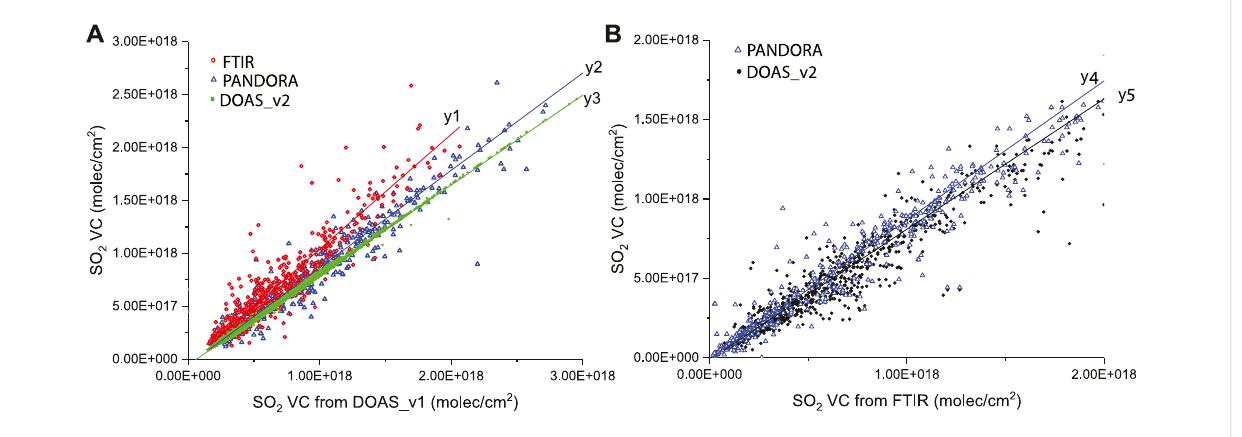
FIGURE 4 (A) Correlation plot of SO 2 VCs obtained from S2000 DOAS, Pandora, and FTIR instruments. (B) Determination of calibration factors with respect to the FTIR SO 2 product. Fit parameters are reported in Table 3.